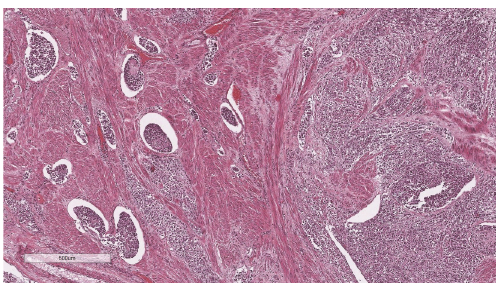
Figure 4: Microscopic examination reveals the presence of an extensive lymphovascular space invasion in the myometrium (H&E staining;